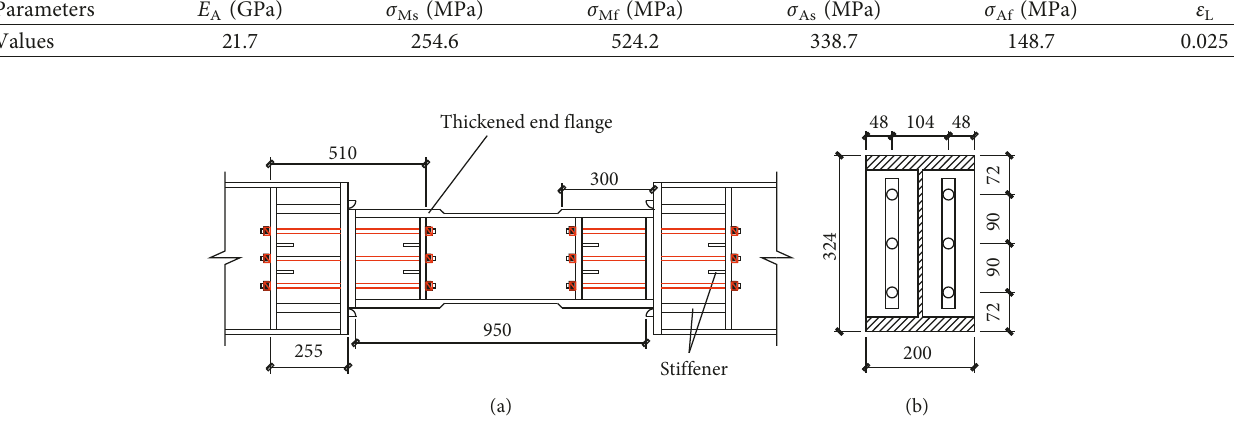
Figure 15: Prototype self-centering link beam considered in FE simulation: (a) self-centering link beam and (b) layout of SMA rods.